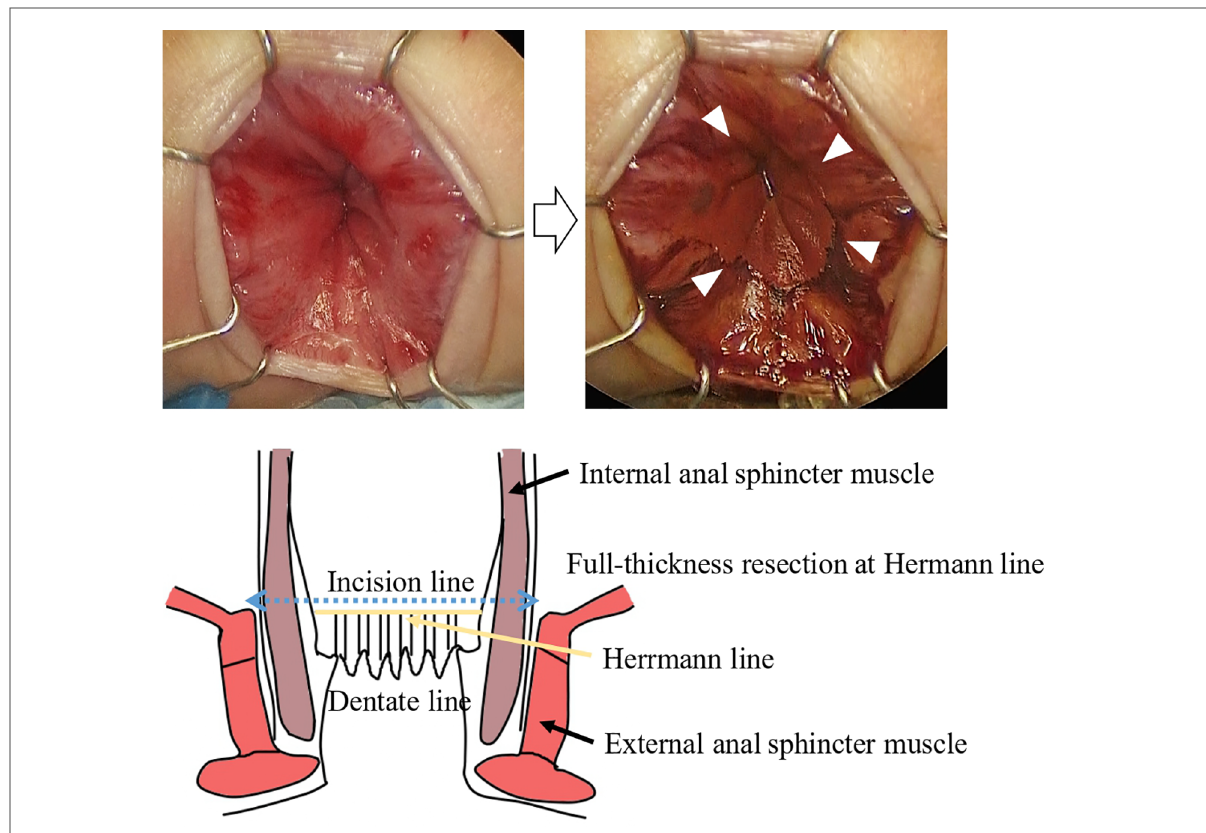
FIGURE 3 Lugol ’ s iodine staining shows a well-demarcated line indicated by arrowheads (herrmann line). This line allows easy identi fi cation of the incision line.